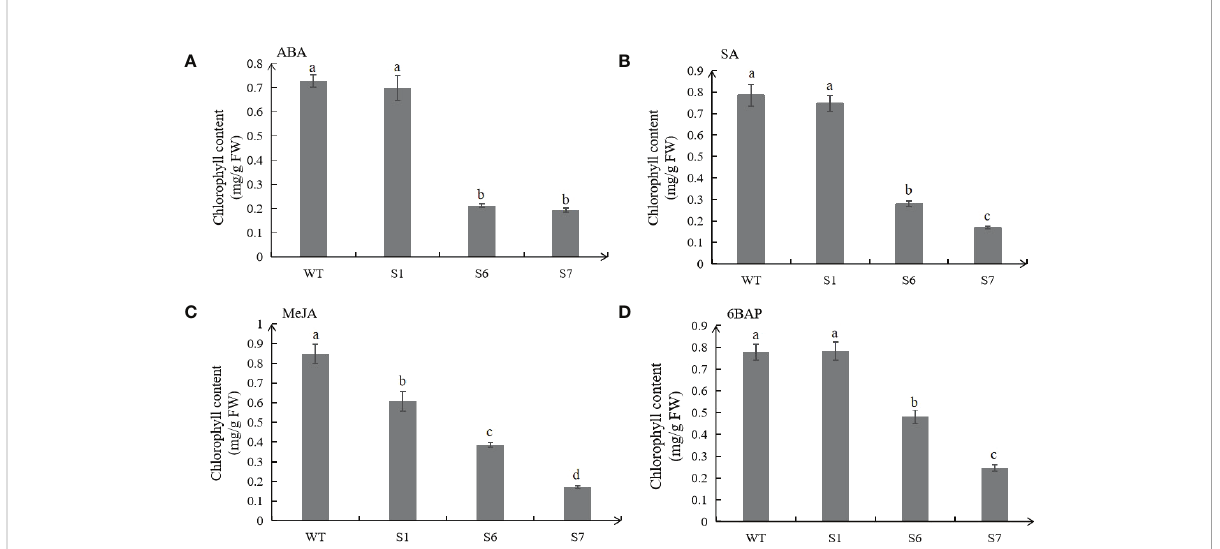
FIGURE 7 Chlorophyll contents in leaves of wild type (WT) and transgenic plants under hormone treatments. Chlorophyll contents of WT and transgenic leaves treated with 50 m M ABA for 5 days (A) . Chlorophyll contents of WT and transgenic leaves treated with 0.5 mM SA for 8 days (B) . Chlorophyll contents of WT and transgenic leaves treated with 10 m M MeJA for 10 days (C) . C hlorophyll contents of WT and transgenic leaves treated with 10 m mol/L 6BAP for 12 days (D) . The values are means ± SD (n = 3). In graphs, bars with different lowercase letters indicate signi fi cant difference at